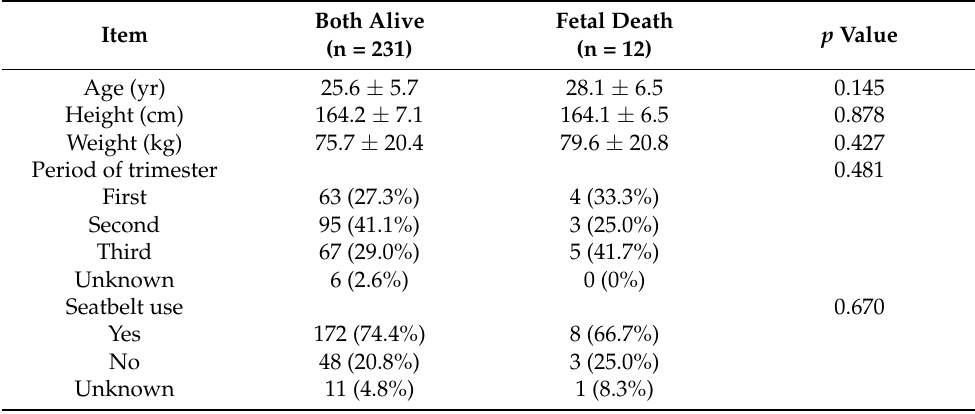
Table 3. Background and collision characteristics of pregnant women with a positive or negative fetal